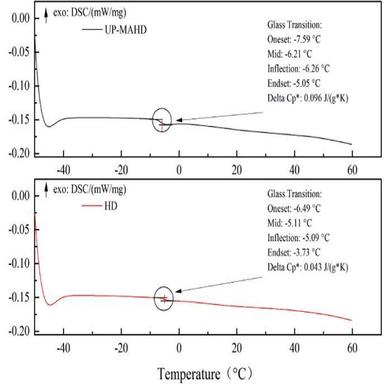
The phase transition behavior of essential oil.